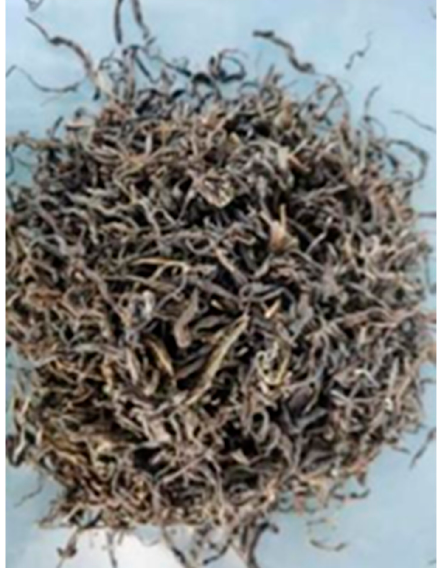
Figure 15. Materials of Lan tea.